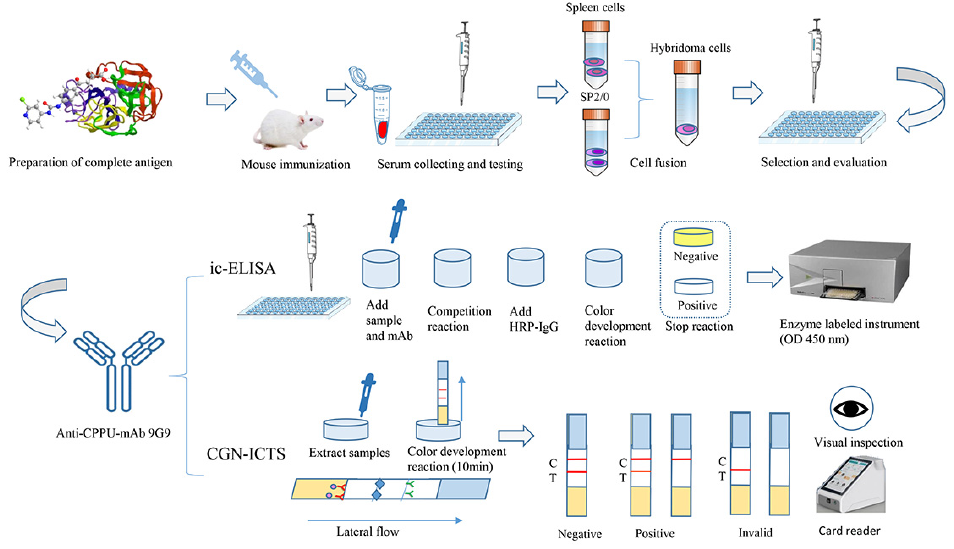
Figure 1. A schematic diagram for detecting CPPU.